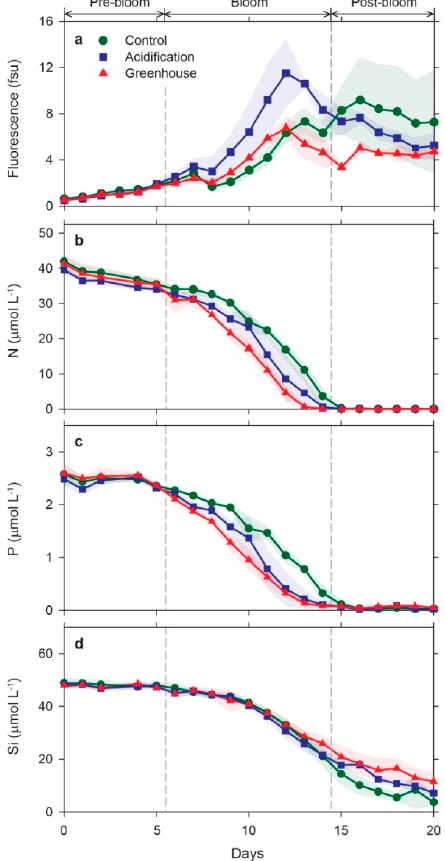
Figure 3. Changes in ( a ) fluorescence, ( b ) N, ( c ) P, and ( d ) Si concentrations during the study